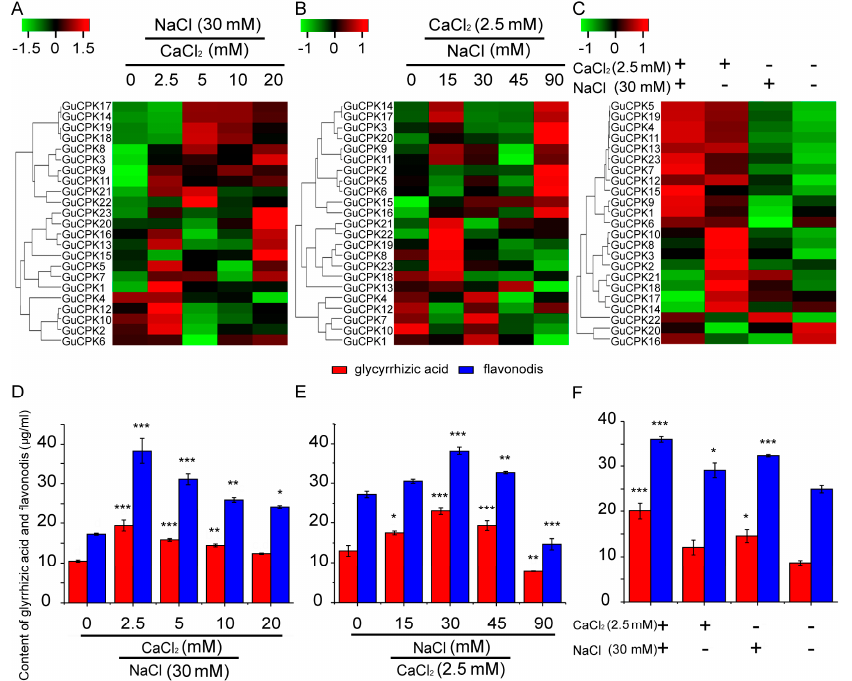
Figure 9. Expression profiles of the GuCPK genes and contents of the glycyrrhizic acid and flavonodis in G. uralensis roots treated by different concentration of CaCl 2 and NaCl. ( A ) Heatmap of GuCPKs expressions at 30 mM of NaCl and different concentration CaCl 2 stimulations. ( B ) Heatmap of GuCPKs expressions at 2.5 mM of CaCl 2 and different concentration NaCl stimulations. ( C ) Heatmap of GuCPKs expressions at different formulations of with or without treatments of 2.5 mM of CaCl 2 and 30 of mM NaCl. Each value denotes the mean relative level of the expression of three independent replicates. GuCPK genes with higher or lower expressions in different treated tissues were colored by red or green, respectively. The color bars are shown at the upper apex. The qRT-PCR-based heatmap was visualized by R package. The contents of glycyrrhizic acid and flavonoids were measured under the treatments of 30 mM of NaCl and different concentrations of CaCl 2 ( D ), and 2.5 mM of CaCl 2 and different concentrations of NaCl ( E ), as well as different formulations with or without 2.5 mM of CaCl 2 and 30 mM of NaCl ( F ). Red and blue represent the contents of glycyrrhizic acid and flavonoids, respectively. Each value represents the mean relative level of the expression of three independent experiments. The data are indicated as mean values ± SD. Asterisks indicate significant differences based on Student’s t -test using the materials without any addition of CaCl 2 or NaCl as controls, * p < 0.05; ** p < 0.01; *** p < 0.001.